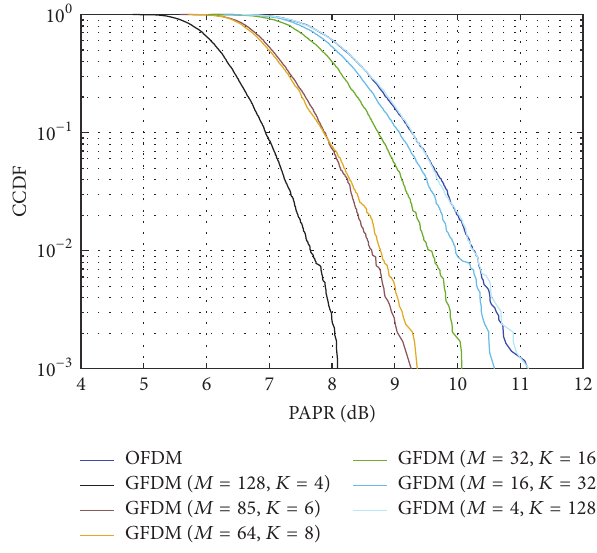
Figure 11: PAPR comparison between OFDM and GFDM (QPSK, 𝛼 = 0.1